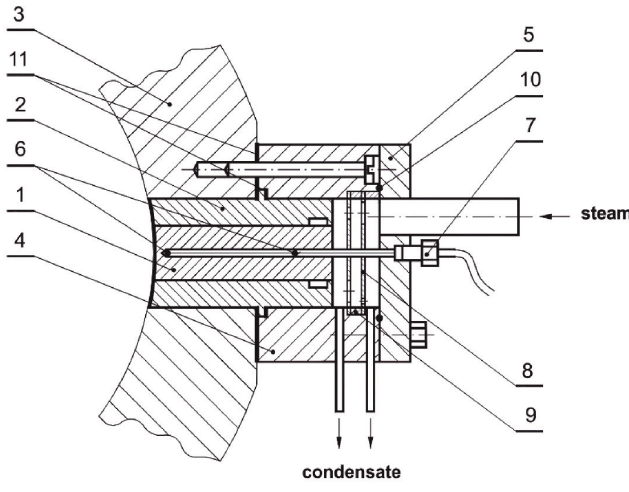
Fig. 3 – Scheme of the local heat flux meter: l – measuring cylindrical element; 2 – surrounding ring; 3 – wall of the agi­ tated vessel; 4 – sleeve; 5 – cover; 6 – thermocouples; 7 – gland; 8 – out dropping plates; 9 – distance ring; 10 –